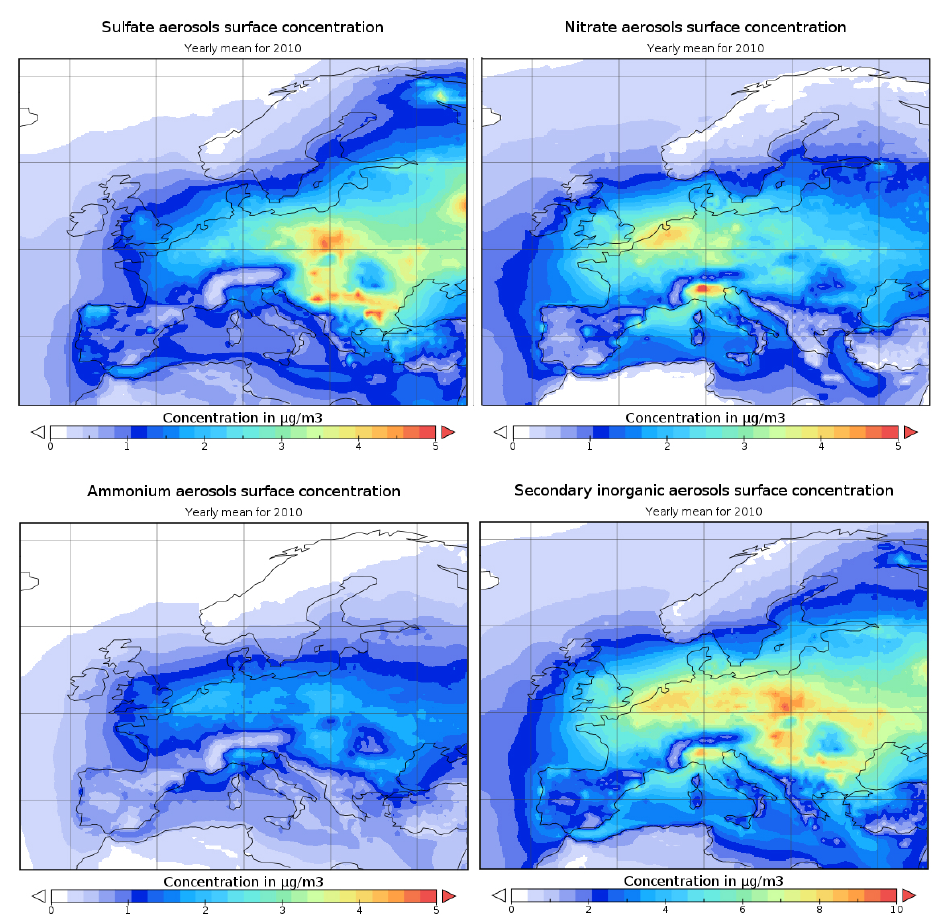
Figure 10. Maps of regional annual mean concentrations, in µgm − 3 , of secondary inorganic aerosol components over a regional domain for the year 2010 for the RACMSIA simulation. The top left panel represents sulfate concentration, the top right nitrate, the bottom left ammonium, and the bottom right represents the sum of these three SIA components. Table 6. Secondary inorganic aerosol compound statistics of RACMSIA simulation daily HTAP